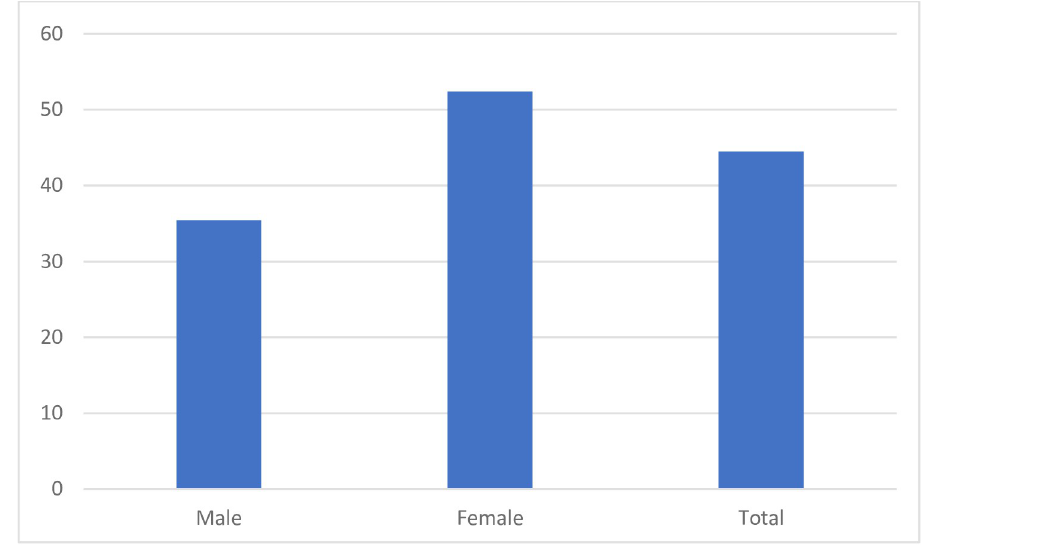
Fig 1. Functional disability by gender among older adults in India (LASI